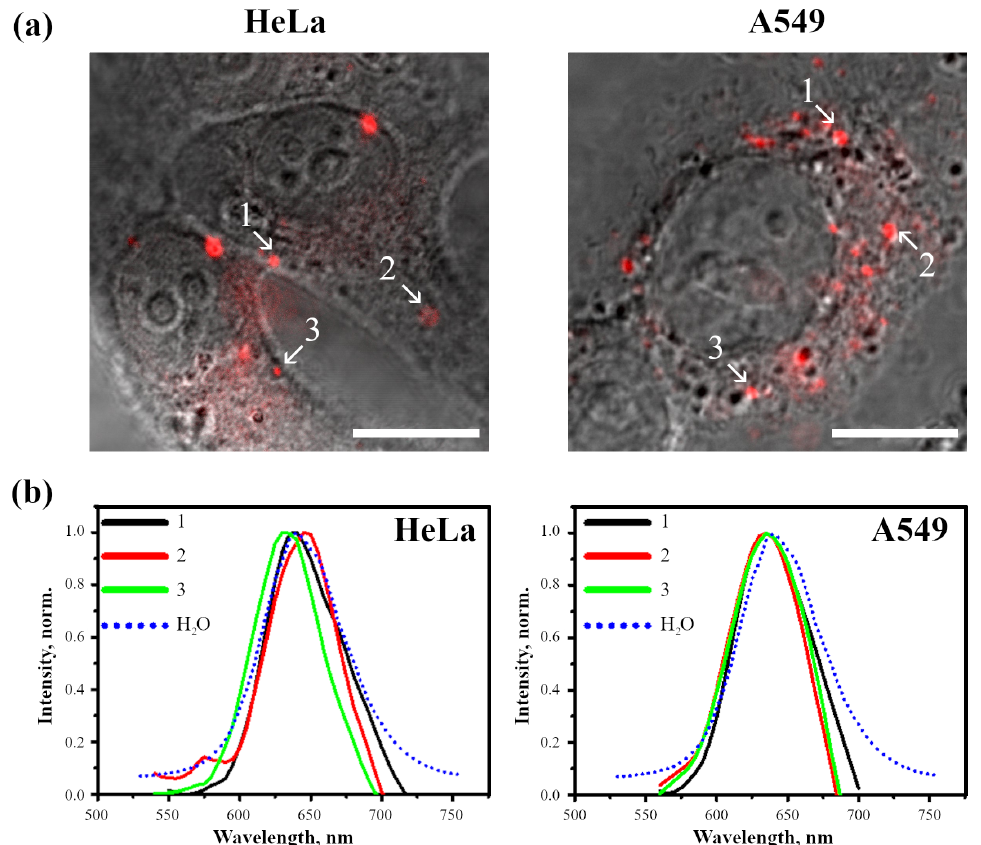
Figure 6. Spectral scanning of InP-QD clusters in cells (20 nM, 24 h) obtained with a confocal microscope and the spectra of the same InP-QDs in H 2 O. ( a ): Confocal images of HeLa and A549 cells. The arrows indicate the selected areas (1–3) for InP-QD spectral scanning. ( b ): Fluorescence spectra of InP-QDs in H 2 O and in the selected areas (1–3) of the cells in ( a ). For comparison, the spectra were normalized for the maximum intensity value in each case. Scale bars 10 µ